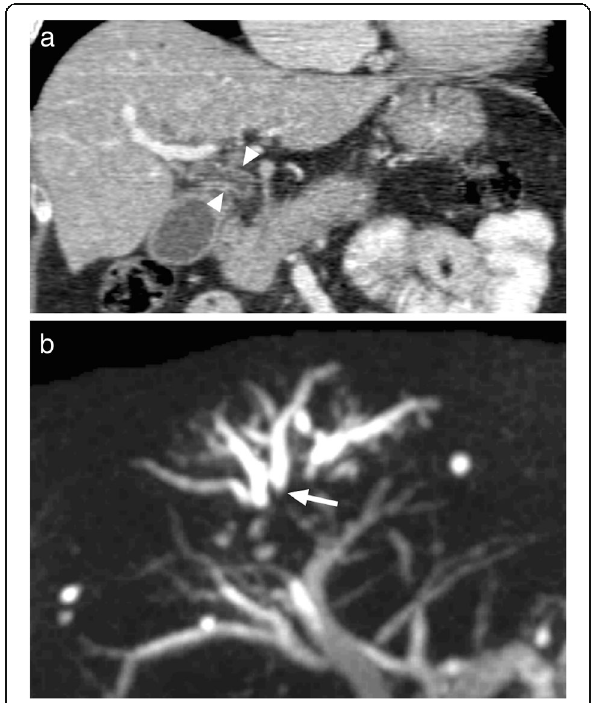
Fig. 26 A 43-year-old male presented with jaundice and right upper quadrant pain. a Coronally reformatted postcontrast CT image demonstrates diffuse wall thickening in the common bile duct (arrowheads). b Coronal plane MIP image from the MRCP study demonstrated abrupt segmental obstruction (arrow) within the same segment. Also note dilated proximal intrahepatic bile ducts. Brush biopsies obtained from endoscopic sampling were